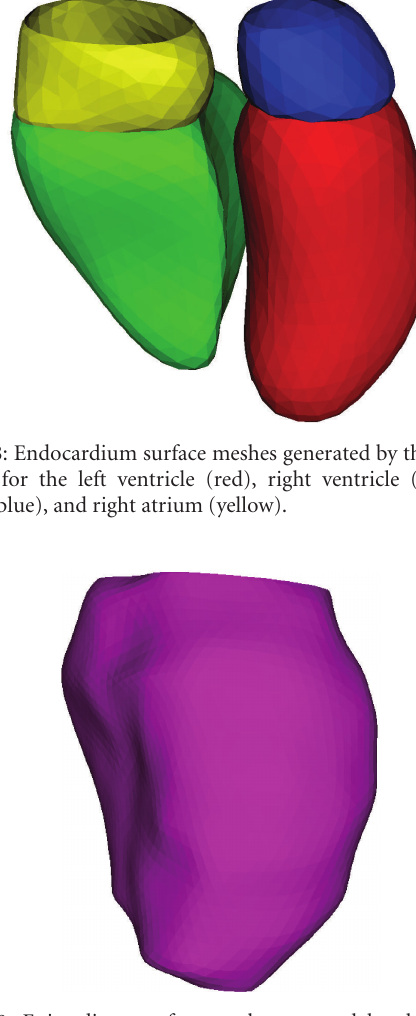
Figure 9: Epicardium surface mesh generated by the proposed method for the entire